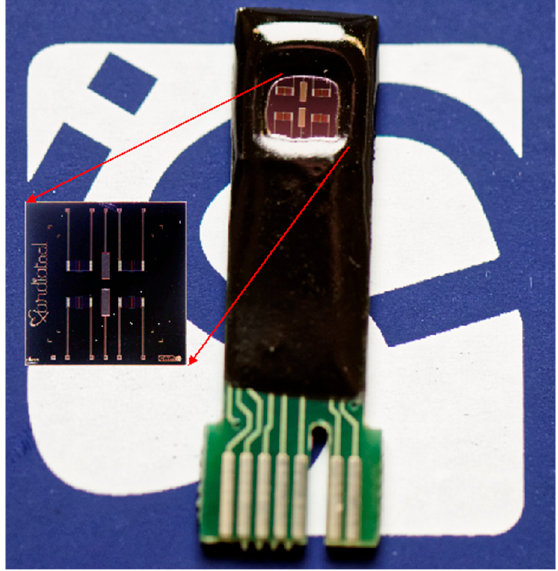
Figure 1. Photograph of the encapsulated chip containing four ion-sensitive field effect transistors (ISFETs), Ag/AgCl reference microelectrode and Pt counter microelectrode.